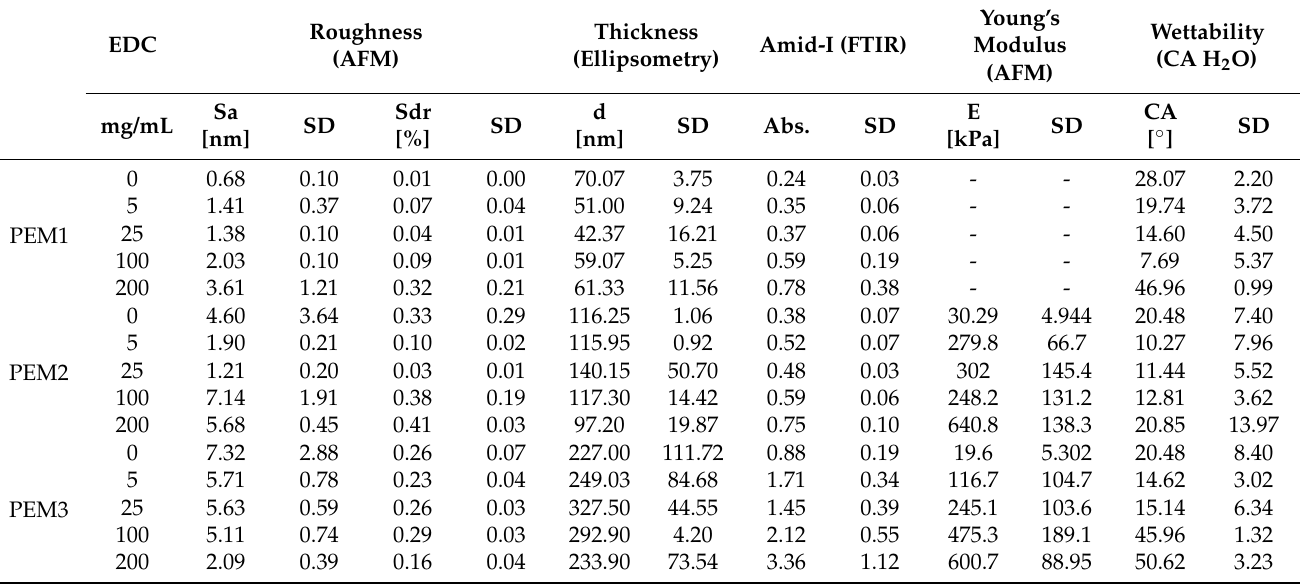
Table 1. Summarized results from physicochemical investigations as published and discussed in detail in